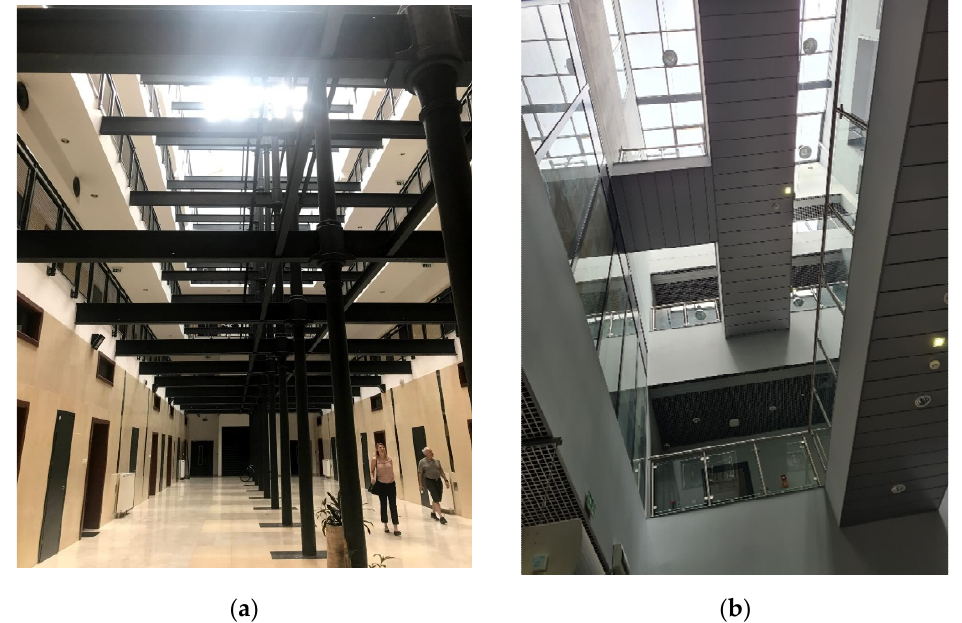
Figure 3. Complex atrium examples: ( a ) beams in the atrium space (photograph courtesy of Brzezi ń ska); ( b ) balconies in the atrium space (photograph courtesy of Brzezi ń ska).